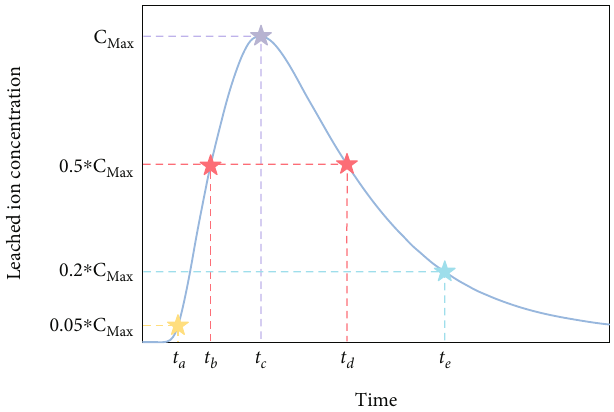
Figure 10: Schematic diagram of representative moments of rare earth ion leaching